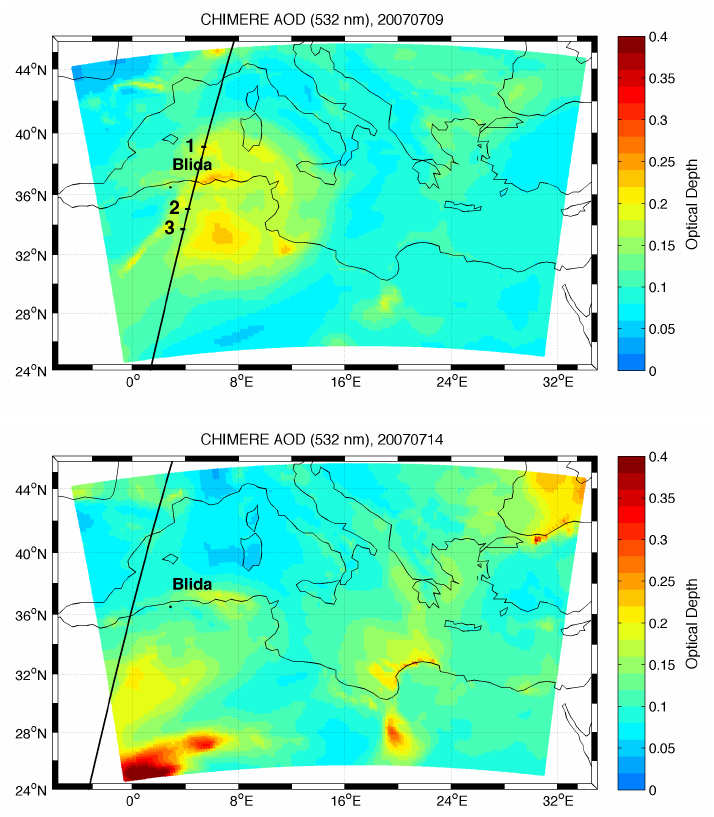
Fig. 12. Aerosol Optical Depth modeled with CHIMERE for λ = 532nm for the 9 and 14 July 2007 at the same hour as the CALIPSO overpass time.